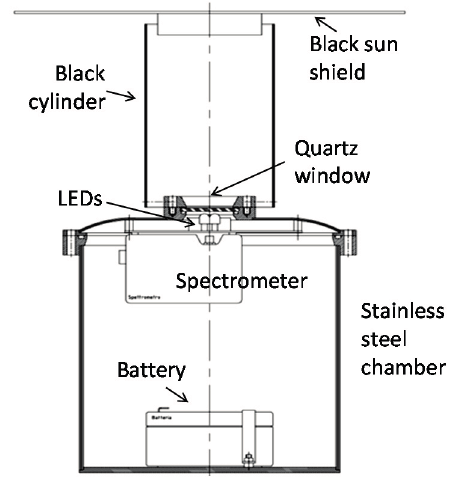
Figure 3. Technical drawing of the external